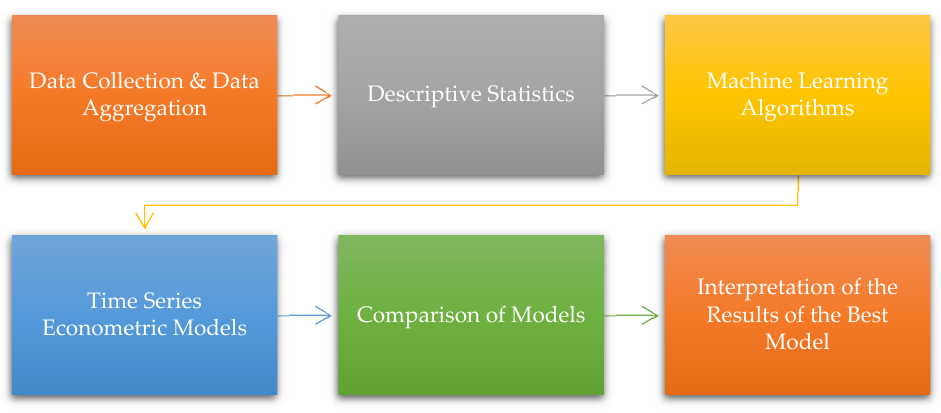
Figure 1. The proposed empirical model.